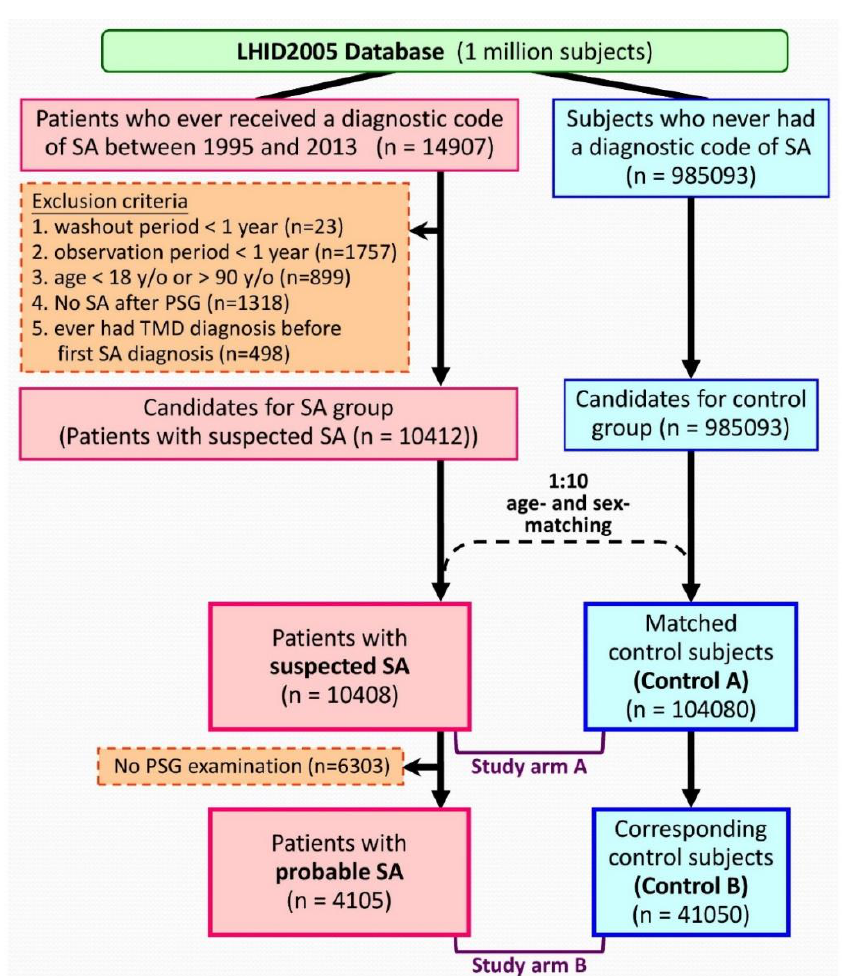
Figure 1. Algorithm to identify the study population. Abbreviations: LHID2005 = Longitudinal Health Insurance Database 2005; SA = sleep apnea; TMD = temporomandibular disorder; PSG = polysomnography; y/o = years old.